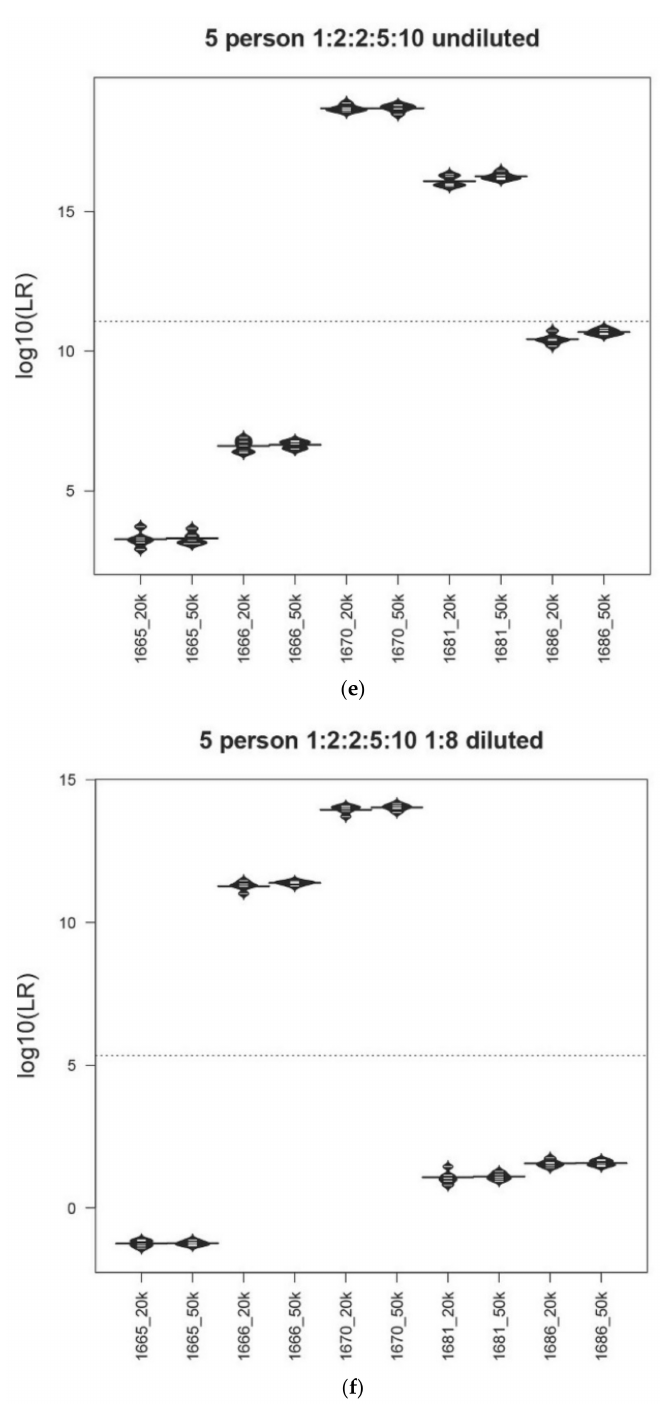
Figure 1. Precision in the MaSTR™ system. Bean plot representation of the average LRs and as- sociated standard deviations for each contributor in a range of mixture ratio and DNA template quantity conditions. The average (N = 5) LR values for each contributor in the analyses using the different number of MCMC iterations per chain are shown for comparison (log10of the LRs on y -axis). ( a ) 5K/chain or 10K/chain for two-person (~500:500 pg), ( b ) 10K/chain or 20K/chain for three-person (~500:500:500 pg), ( c ) 20K/chain or 50K/chain for four-person (~50:50:150:500